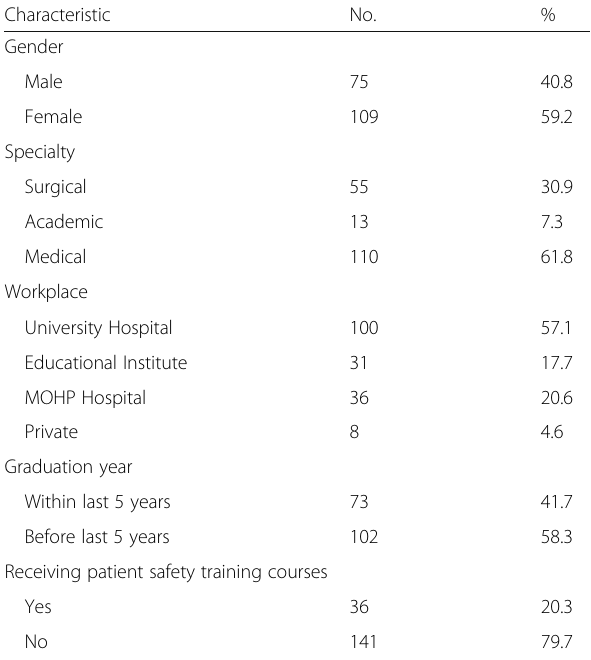
Table 1 Personal characteristics of participated physicians in the Faculty of Medicine, Cairo University, 2017/2018